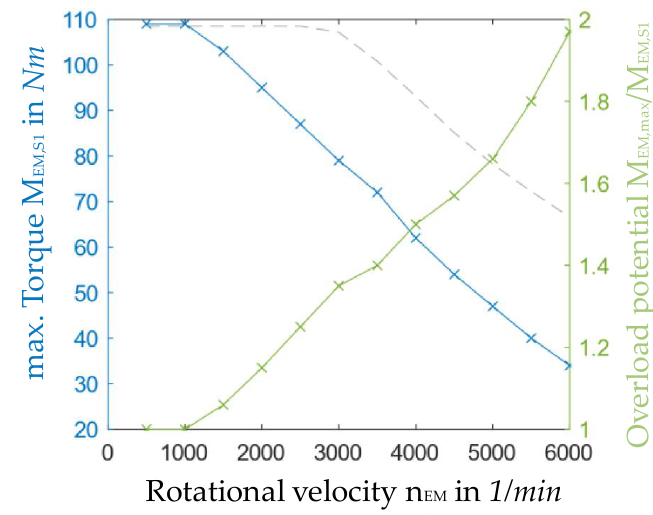
Figure 9. Simulative overload potential of the IM for the NEmo.